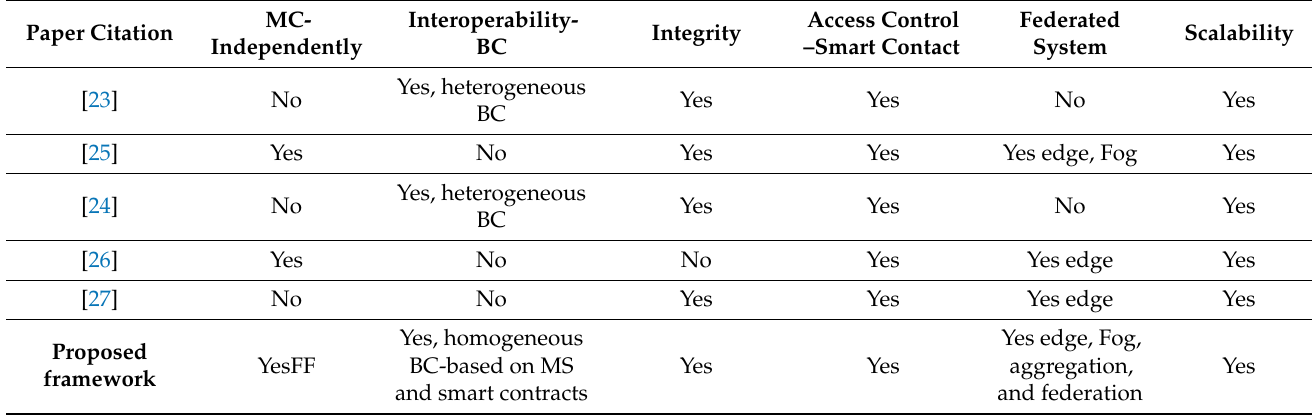
Table 4. Comparison of our framework with existing solutions.